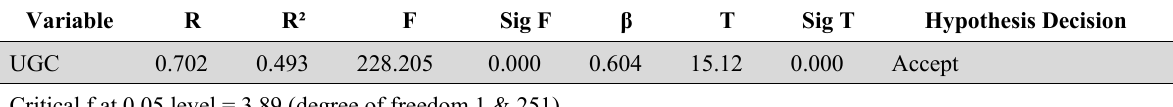
Simple regression test results for the first main hypothesis Variable